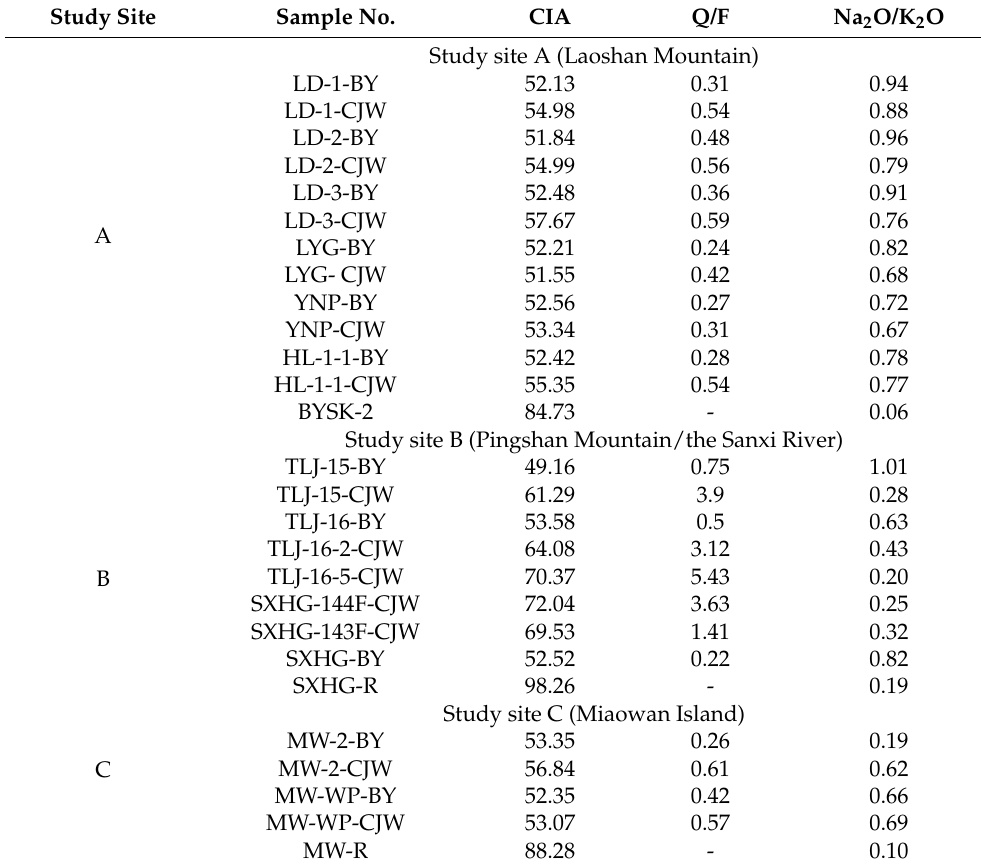
Table 3. CIA, Q/F and Na 2 O/K 2 O values of weathering pits of the three study sites. Study Site Sample No. CIA Q/F Na 2 O/K 2 O Study site A (Laoshan Mountain)